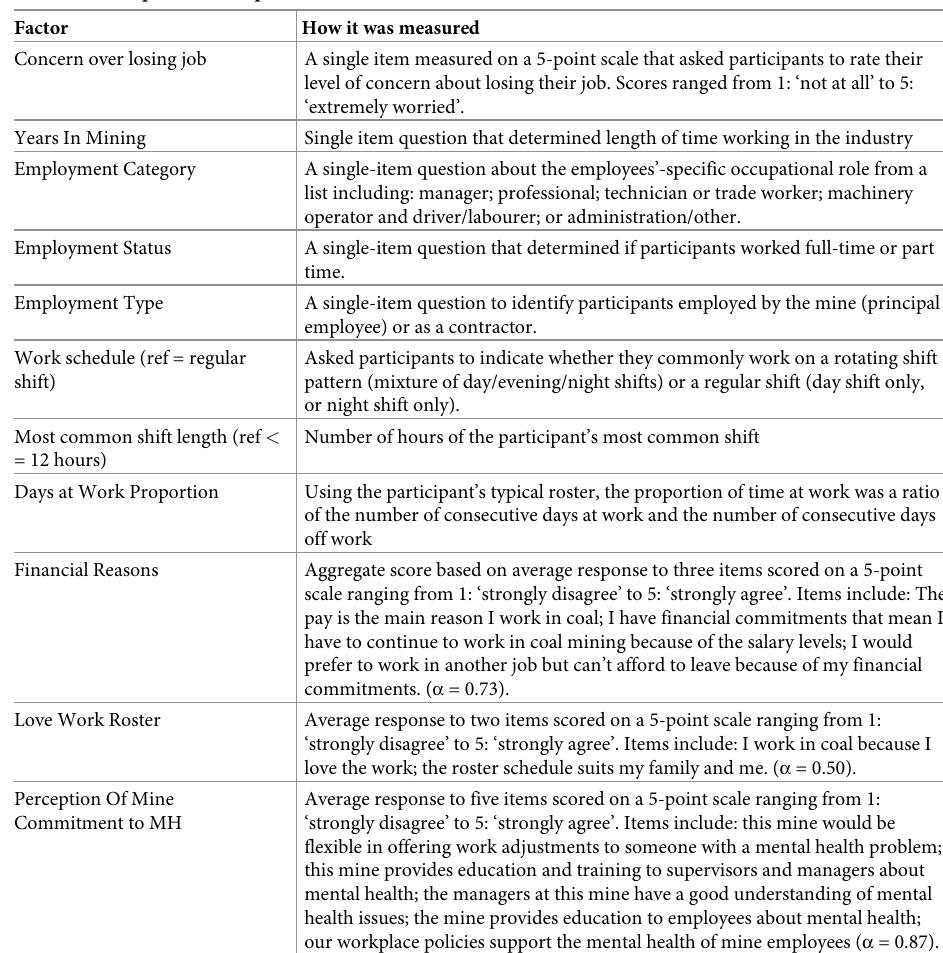
Table 1. Description of workplace factors and attitudes measured.